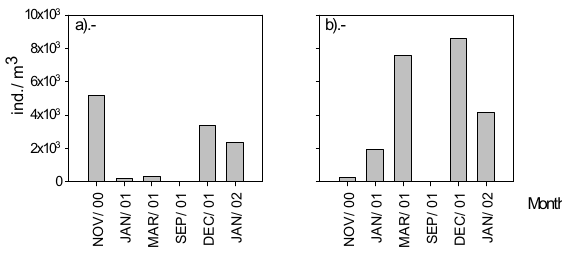
Fig. 2 – Mollusk larvae abundance (ind/m 3 ) variation in Palmar (a) andYí (b) stations. Palmar Reservoir, 2000-2002.